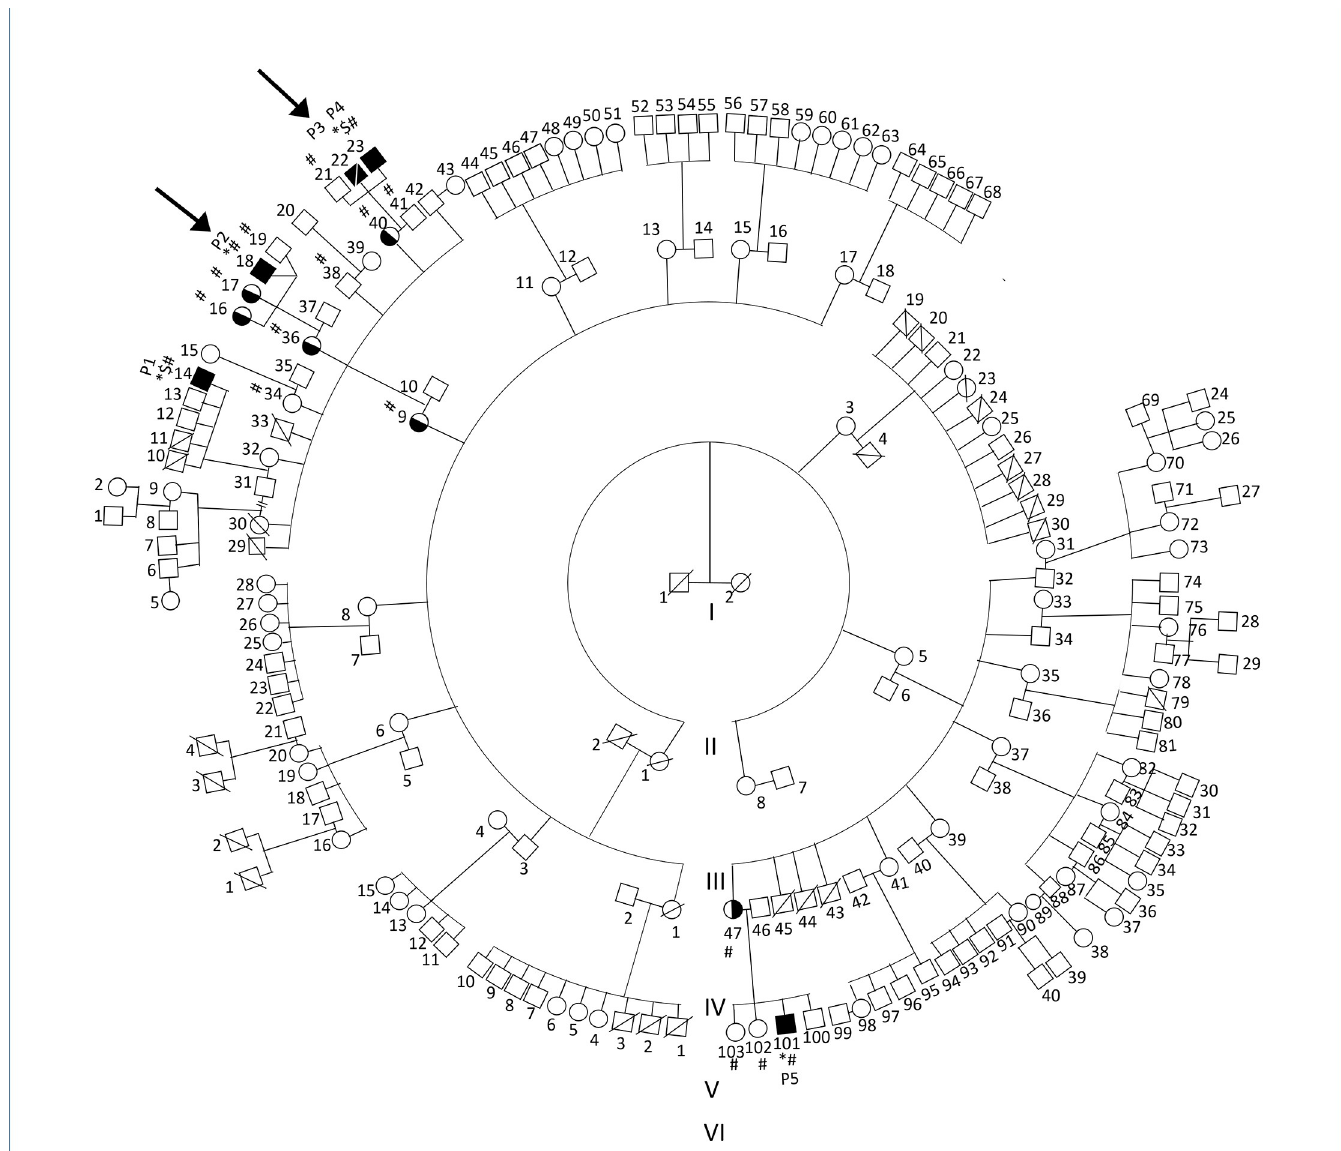
Fig 1. Extended family pedigree of the patients affected with X-linked agammaglobulinemia. Arrow represents two index cases, � —Individuals who underwent whole exome sequencing, $- Individuals who underwent whole genome sequencing, #- Individuals who underwent MLPA.